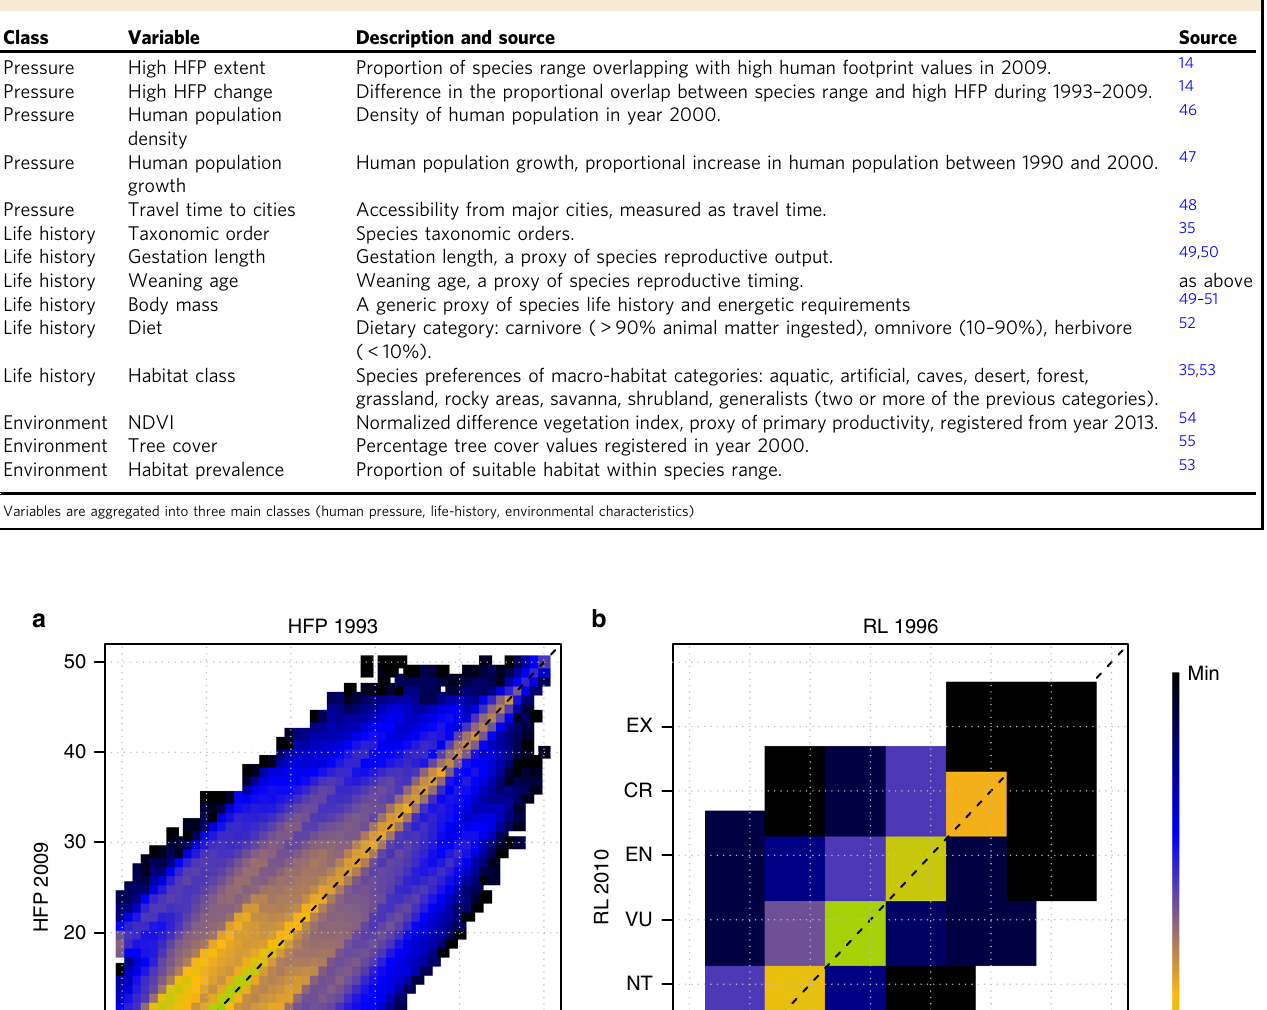
Table 1 Description of the variables used to predict extinction risk transitions in the random forest